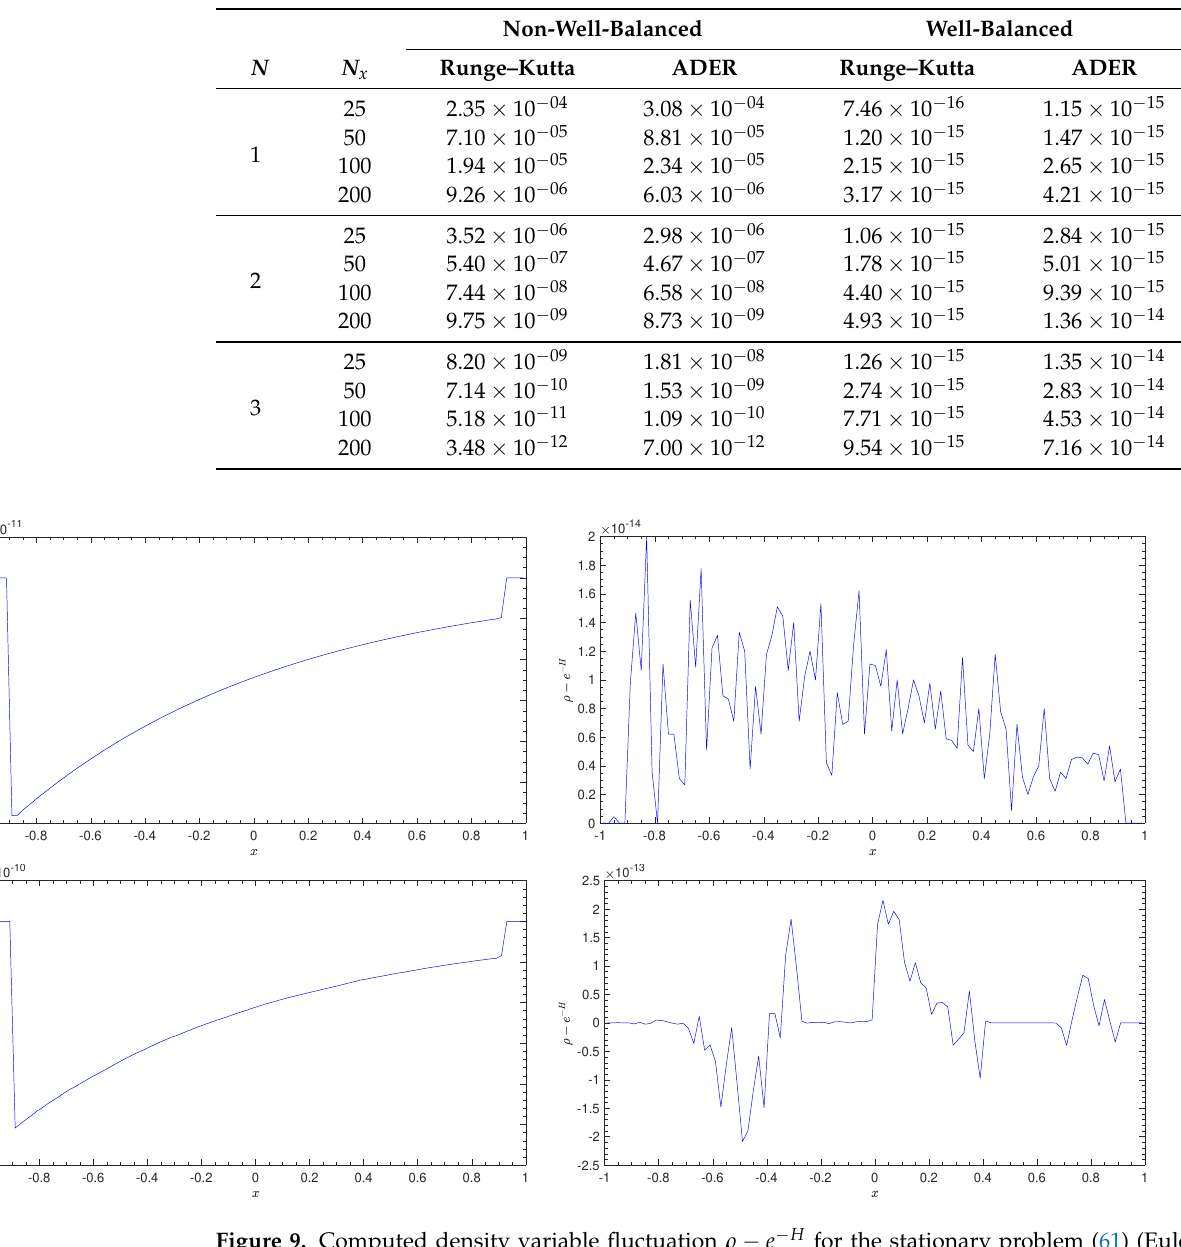
Figure 9. Computed density variable fluctuation ρ − e − H for the stationary problem (61) (Euler equations) at time t = 10 s with the fourth order non well-balanced ( left ) and well-balanced ( right ) methods. An uniform Cartesian mesh of N x = 100 elements has been used. Upper and lower panels stands for Runge–Kutta and ADER time-marching discretisations,